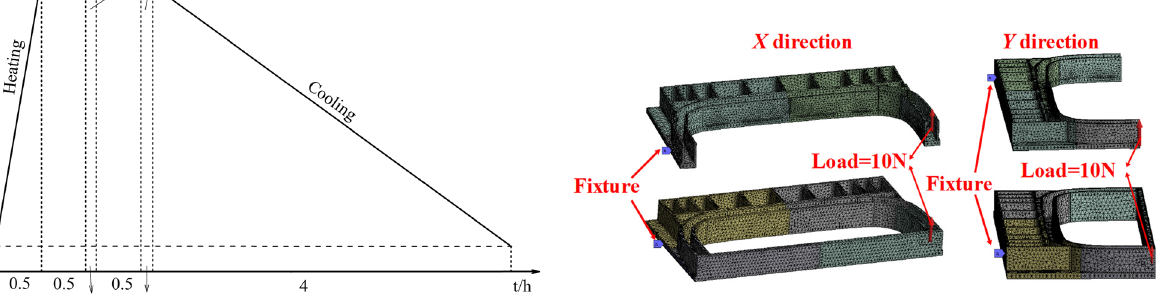
Figure 6: TVSR process fl owchart of Specimen B.